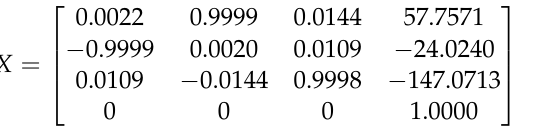
Table 2. Yarn bobbin specifications.